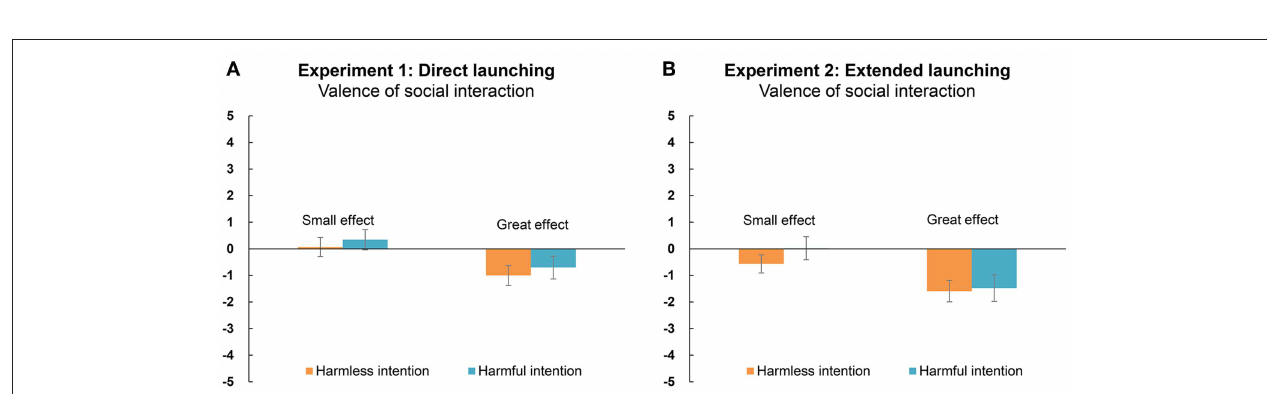
FIGURE 2 | Causality judgment of the actor (i.e., purple hexagon) causing a change in the recipient’s state (i.e., yellow square) under different acting conditions in Experiment 1 (A) and Experiment 2 (B) . A score of 1 means “completely disagree” and 7 means “completely agree.” Error bars indicate the standard errors ( ± SE).